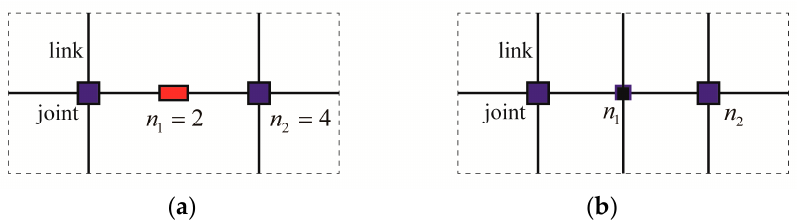
Figure 1. Unit cells of deployable structures assembled by different types of joints, which are designed to respectively connect to n 1 and n 2 links: ( a ) n 1 = 2, and n 2 = 4; ( b ) n 1 = n 2 = 4.